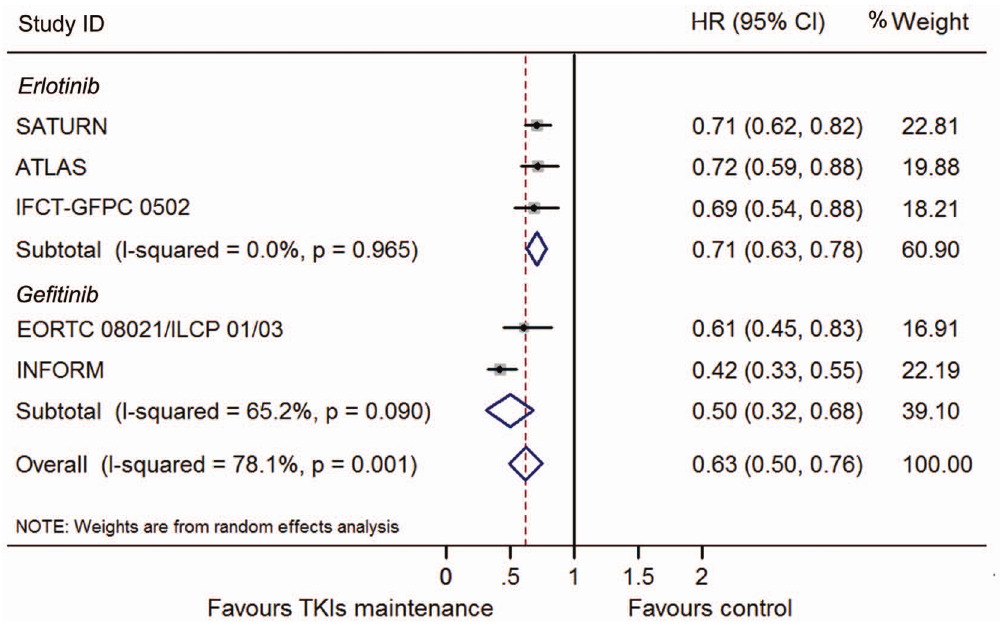
Figure 2. Meta-analysis of hazard ratio (HR) for progression free survival (PFS).